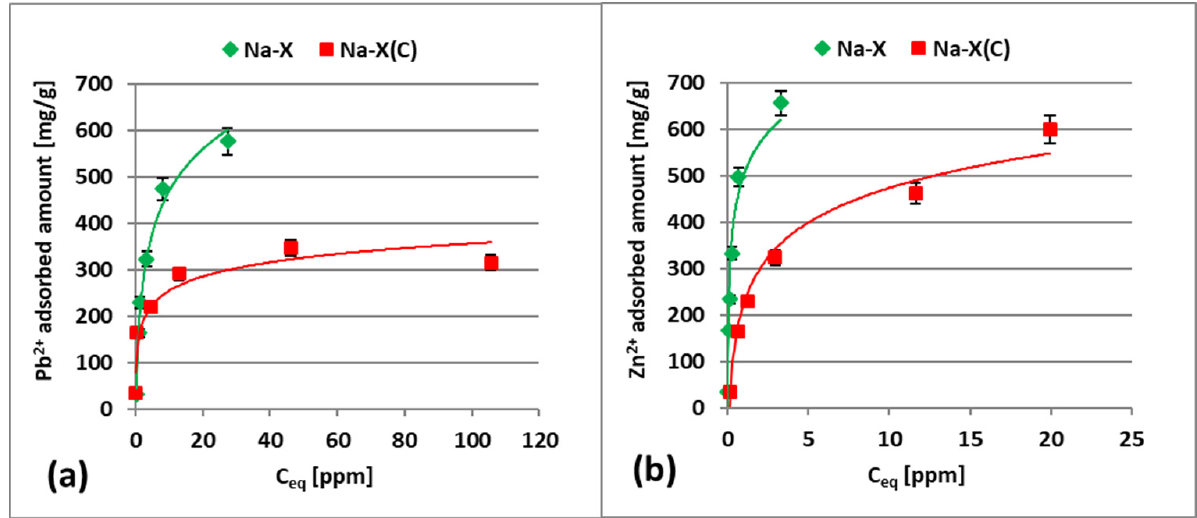
Figure 7. Adsorption isotherms of Pb 2+ ( a ) and Zn 2+ ions ( b ) on the Na-X and Na-X(C) surfaces in the single systems at pH 5.